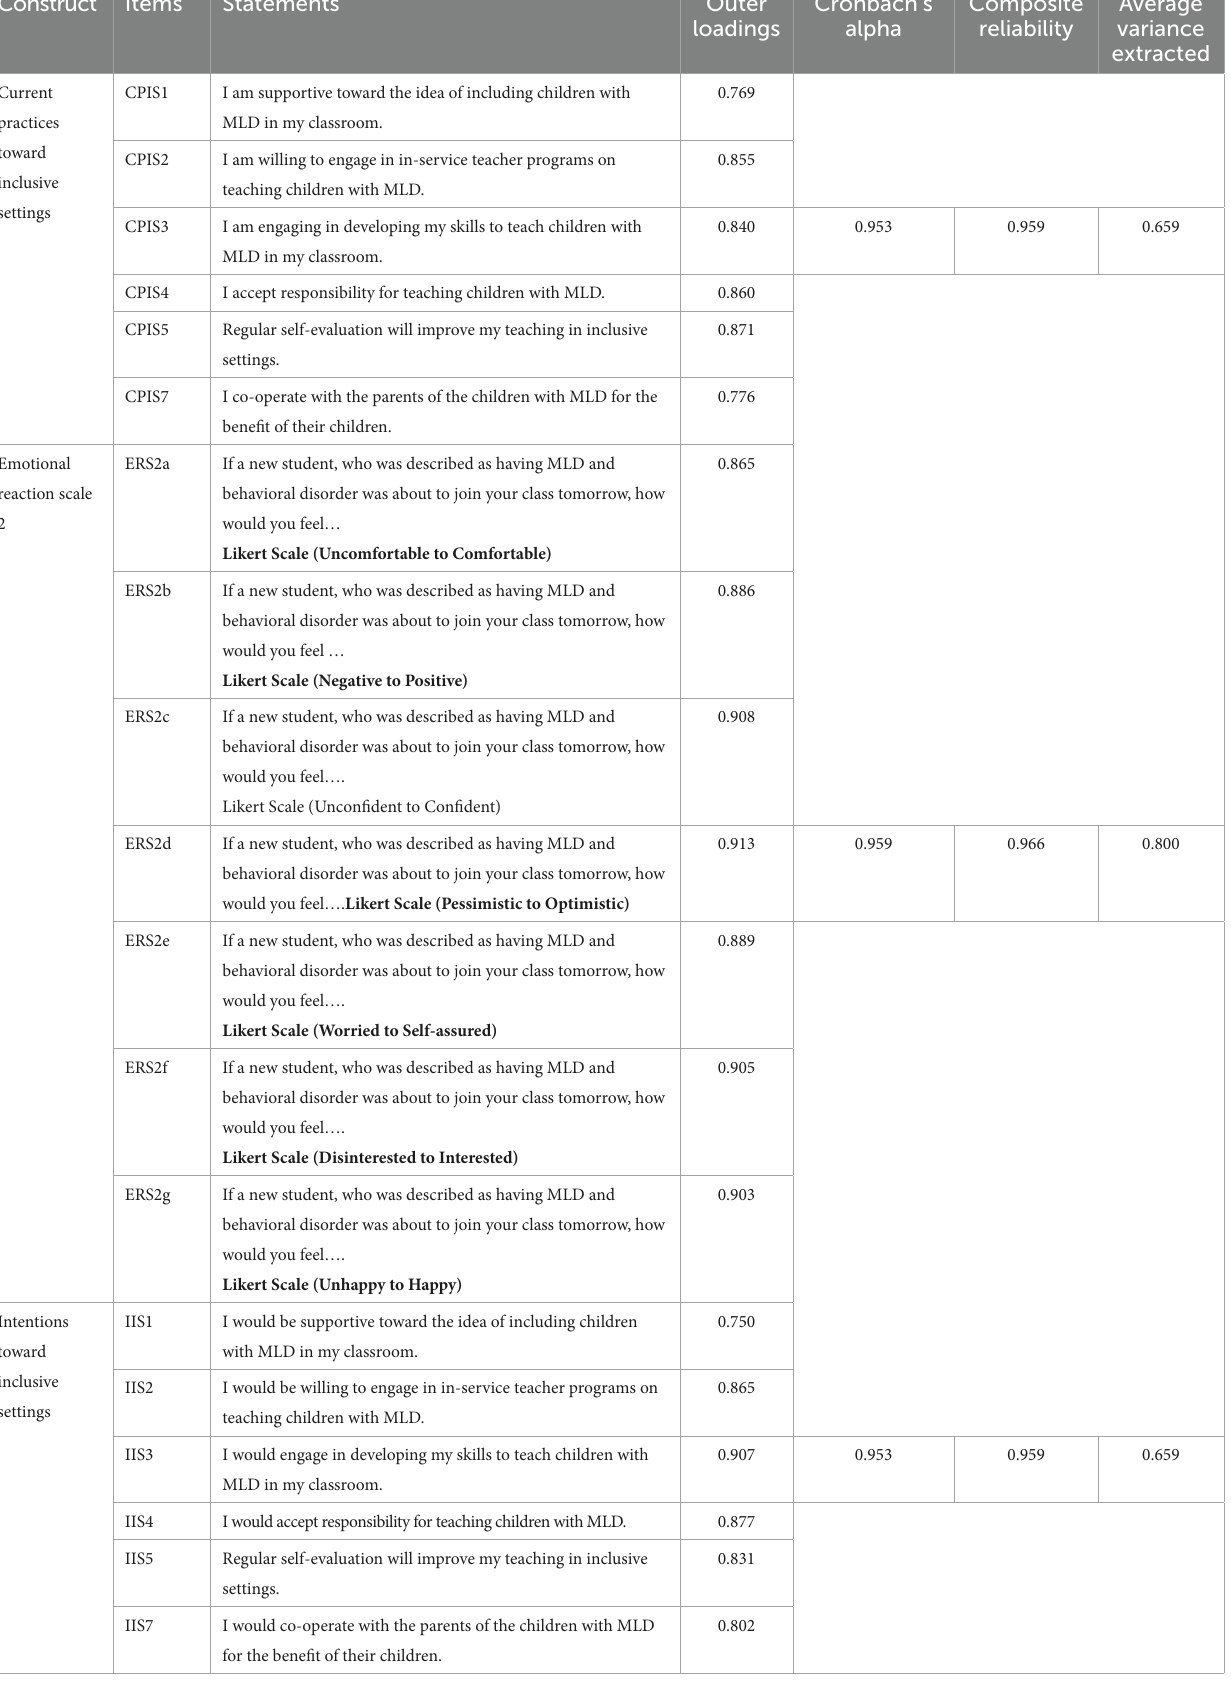
TABLE 1 Outer loadings, reliability, and convergent validity. Construct Items Statements